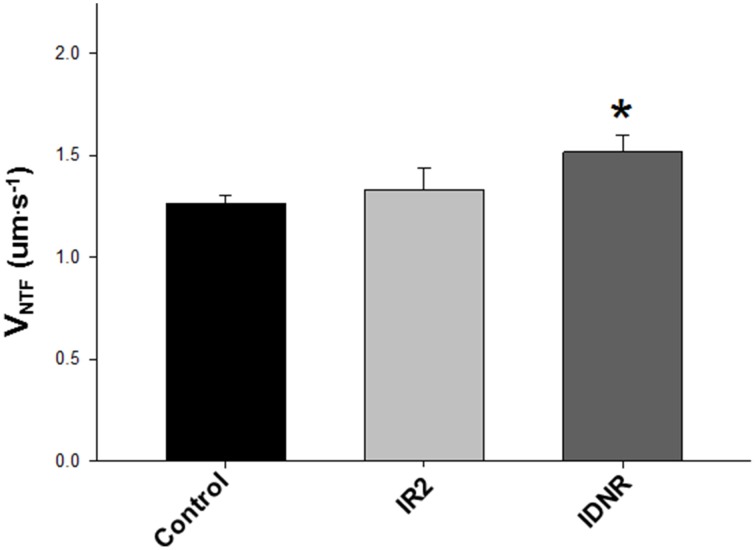
Effect of ischemia/reperfusion on native thin filament velocities (VNTF). Means ± SEM for unregulated (no Tn/Tm) actin filament velocities in the in vitro motility assay using myosin isolated from the corresponding condition. The myosin used was isolated from control, ischemia/2 h of reperfusion (IR2) and Ischemia without resuscitation (IDNR). Data analyzed using a non-parametric Kruskal–Wallis ANOVA and indicated that IDNR was significantly greater than control velocity *, (p < 0.05). The data represent the average actin filament velocities from 20 to 30 s videos from Control, 19 from IR2 and 16 from IDNR.